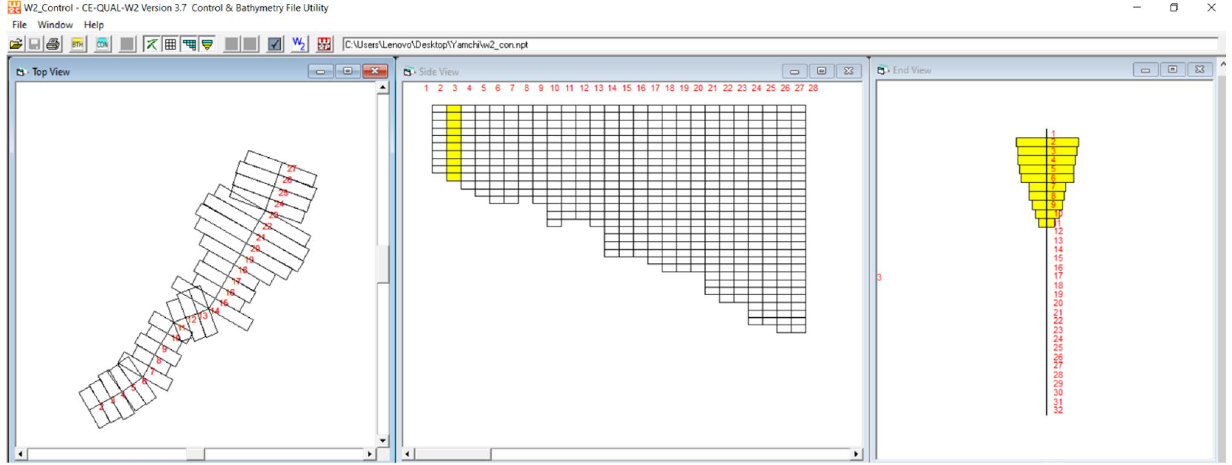
Fig. 2 A view of the reservoir geometry in the CE-QUAL-W2 software